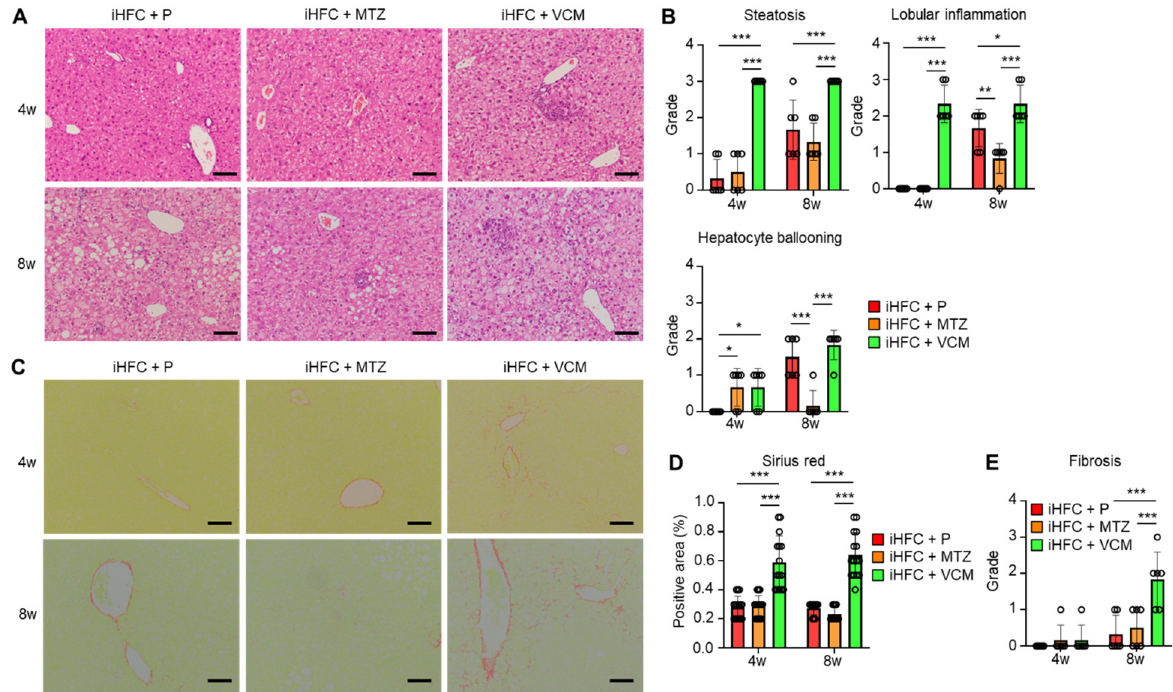
Figure 2. VCM treatment exacerbates iHFC diet-induced steatohepatitis and fibrosis in the liver of TSNO mice. ( A ) Representative images of hematoxylin and eosin-stained sections of the liver from placebo- or antibiotic-treated TSNO mice fed the iHFC diet. Scale bars, 100 μ m. ( B ) Steatosis (0 to 3), lobular inflammation (0 to 3), and hepatocyte ballooning (0 to 2) were assessed according to the criteria proposed by Kleiner et al. as described in Materials and Methods (n = 6 per group). ( C ) Representative images of Sirius red-stained sections of the liver from placebo- or antibiotic-treated TSNO mice fed the iHFC diet. Scale bars, 100 μ m. ( D ) Five locations were photographed in each of three sections in each group. Then, positive areas for Sirius red were measured at 15 locations using ImageJ software Version 1.53t, and the mean and SD were calculated. ( E ) Liver fibrosis (0 to 4) was assessed according to the criteria proposed by Kleiner et al. as described in Materials and Methods (n = 6 per group). Data are shown as means ± SD. * p < 0.05, ** p < 0.01, *** p < 0.001.